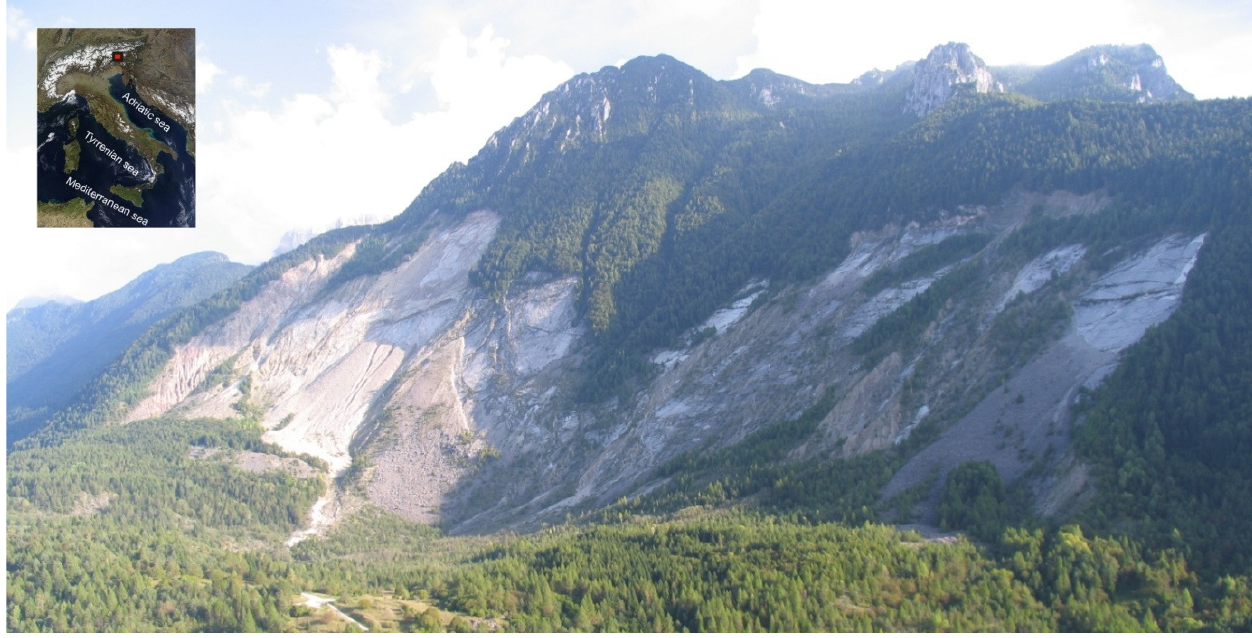
Fig.1. Panoramic view of the slip surface of the Vaiont landslide that occurred on October 9th 1963.